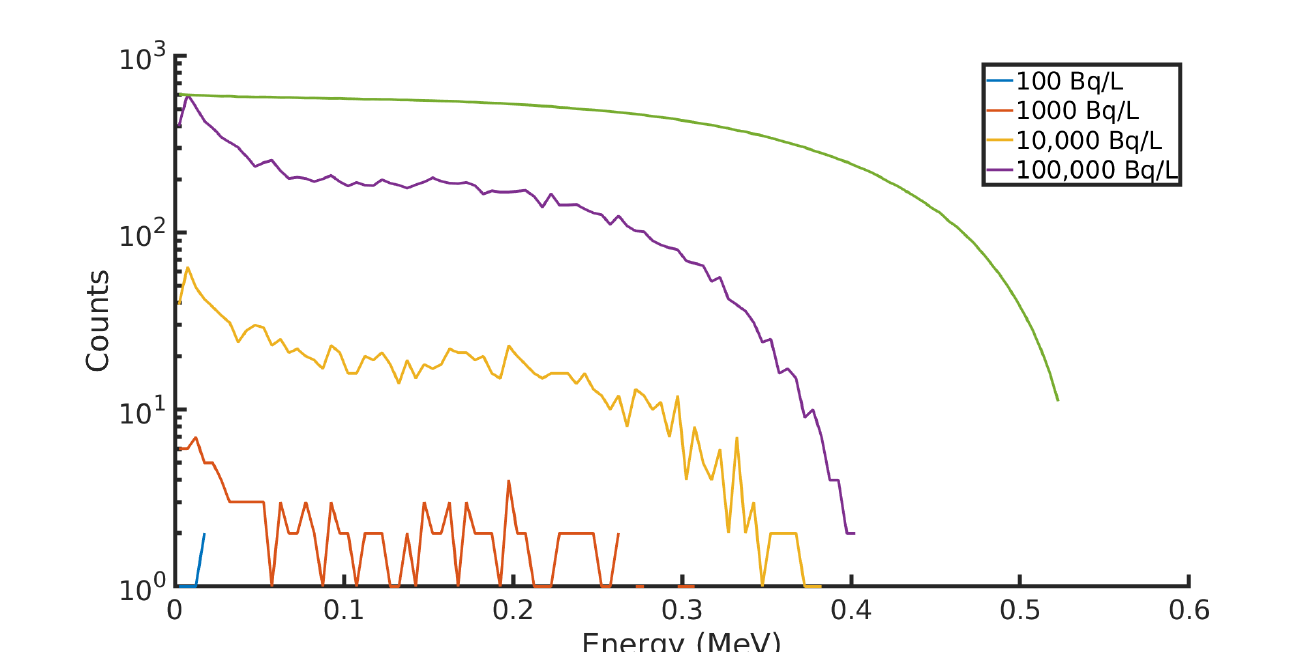
Figure 2. 90 Sr counted in a CdTe detector in a groundwater borehole simulation at different